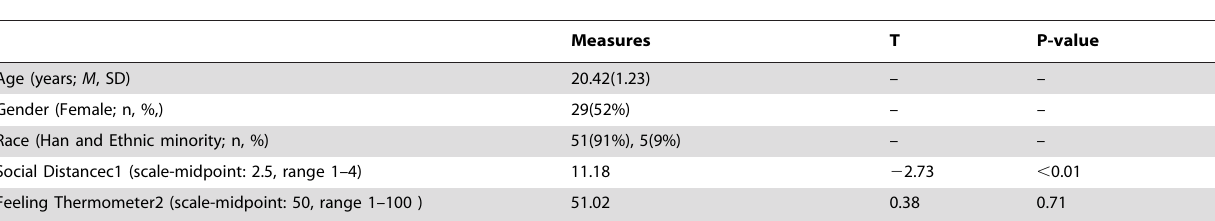
Table 1. Demographic variables and the explicit measures among the